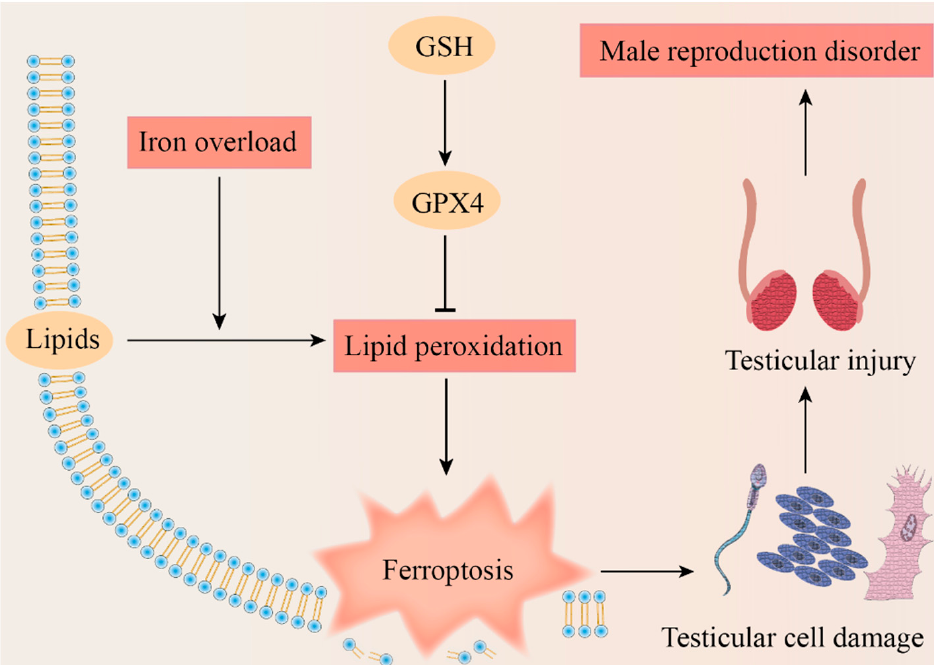
Figure 4. Potential mechanism of ferroptosis leading to male reproduction disorders. The figure illustrates that male reproductive disease could be caused by ferroptosis which results from iron overload, dysregulation of the Cyst(e)ine/GSH/GPX4 axis, and lipid peroxidation. GSH, glutathione; GPX4, glutathione peroxidase 4.